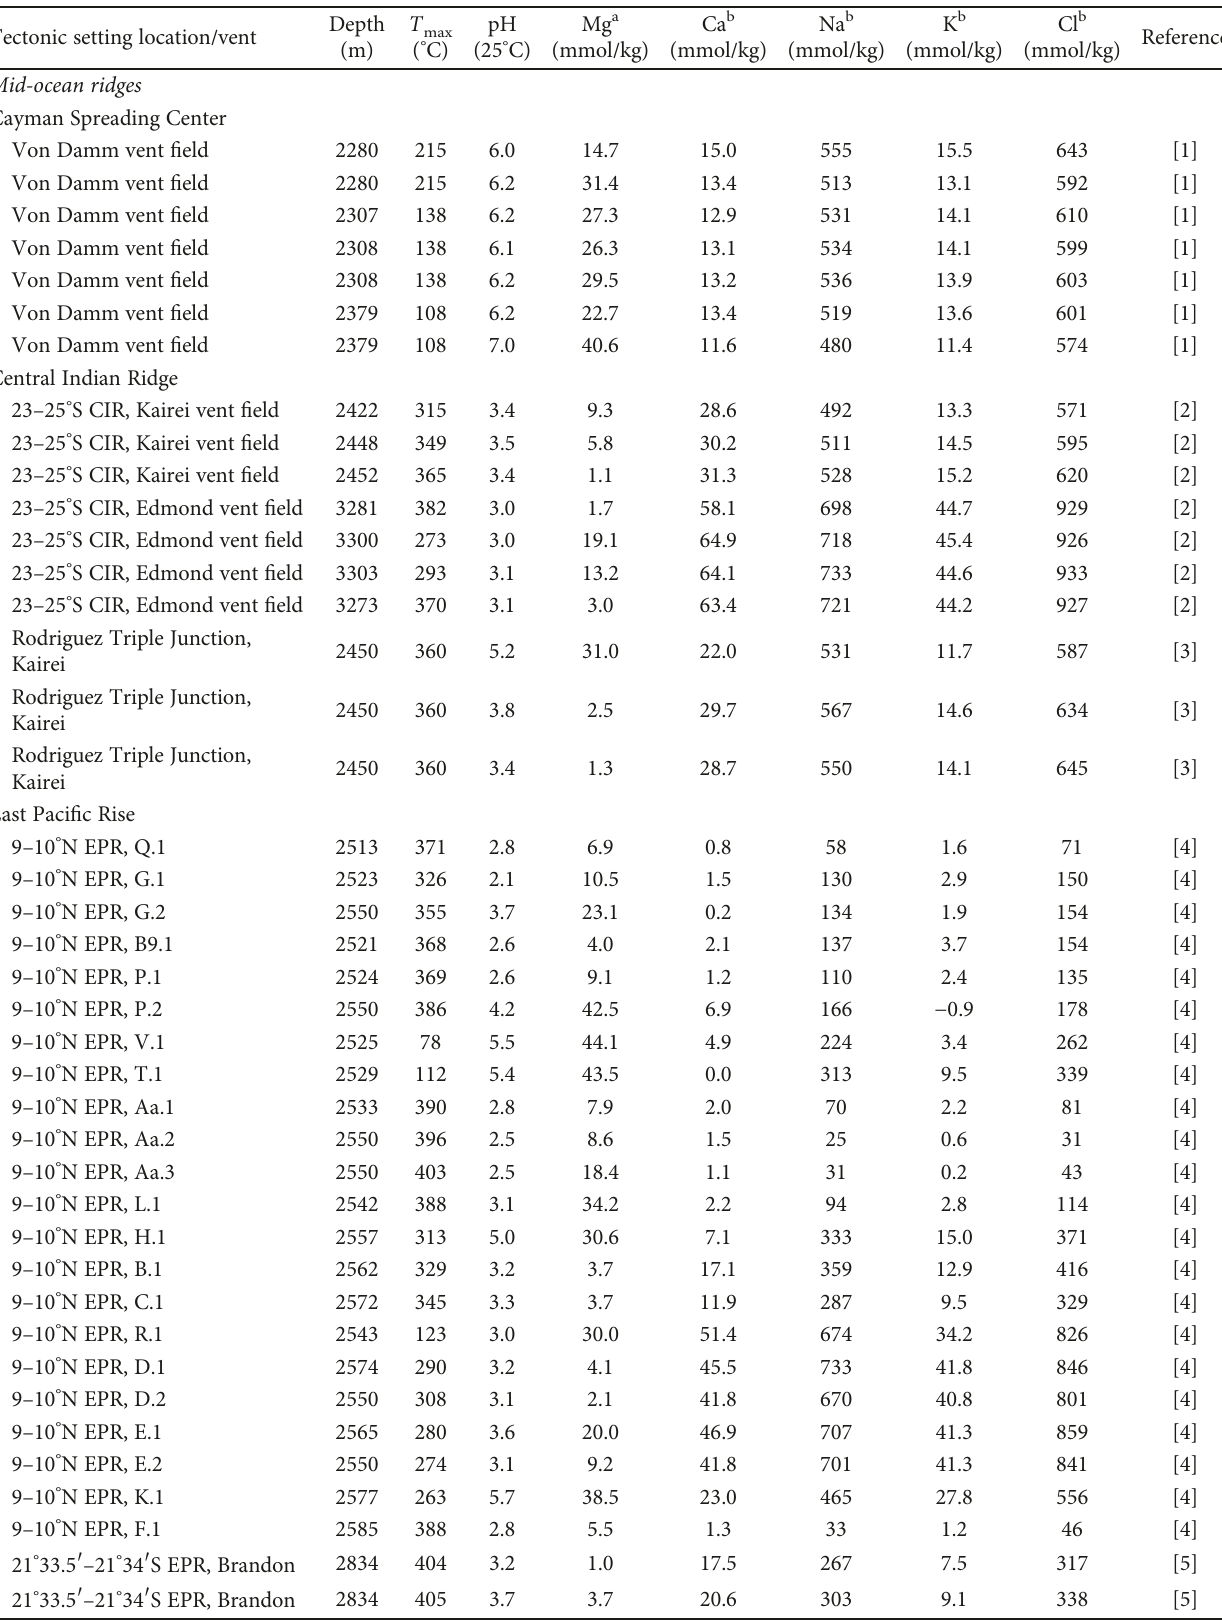
Table 2: Compilation of major element compositions of fl uids from selected basalt-hosted sea fl oor hydrothermal vents. Tectonic setting